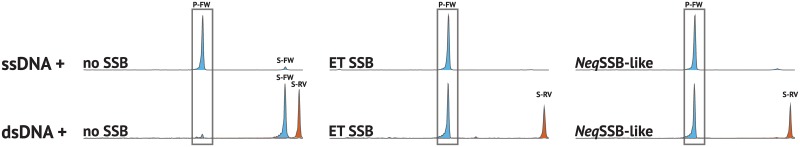
NeqSSB-like protein provides similar enhancements to TtAgo activity as ET SSB.CE traces showing the ability of TtAgo to cut linear dsDNA substrates only in the presence of a thermostable SSB protein such as ET SSB or NeqSSB-like protein. The product (P-FW) is boxed for easier identification. The blue trace is from the 5′-FAM of the forward strand of the substrate (S-FW), and the red trace is from the 3′-TAMRA of the complement strand of the substrate (S-RV). Reactions were carried out using optimal-length 16 nt guides at 73 °C for 8 hr to demonstrate the low activity of TtAgo in the absence of SSB on dsDNA substrate. Only in reactions containing SSB could TtAgo cut dsDNA substrate. From left to right, reactions contained: no SSB; 1.2 μM ET SSB; and 420 nM NeqSSB-like protein.